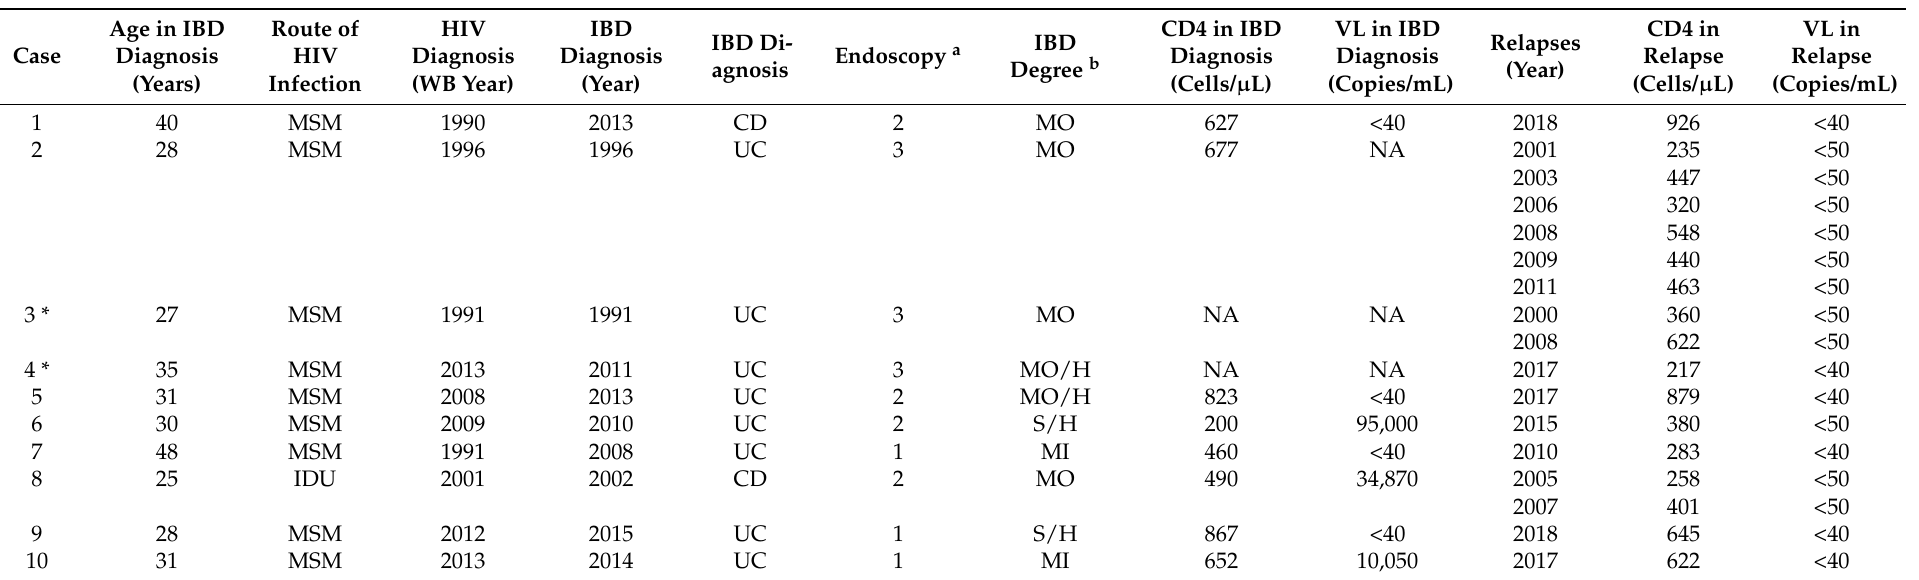
Table 3. The characteristic of patients with IBD